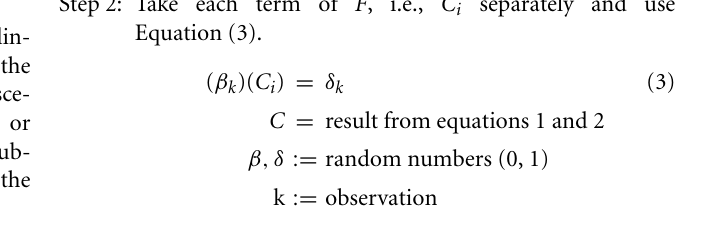
gram positive; GN, gram negative; P, plants and algae; NP, non-plants. Nomenclature for enzyme families, see abbreviations in Figure 2